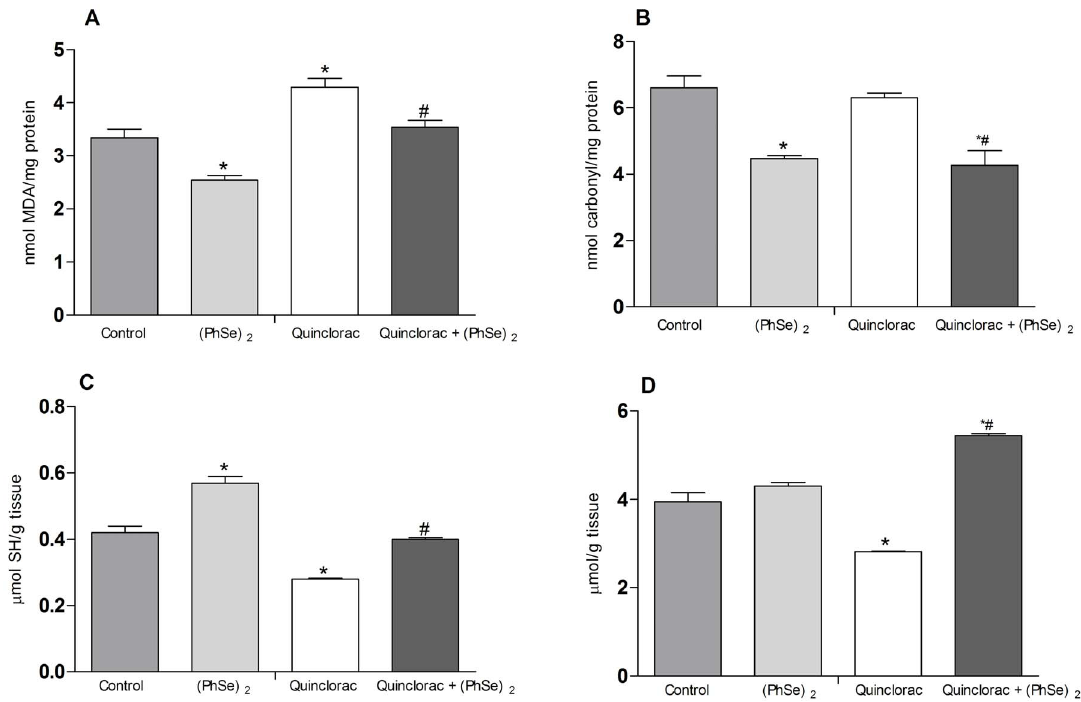
Figure 1. Oxidative parameters and non-enzymatic antioxidants. TBARS (A), protein carbonyl (B), NPSH (C), and ascorbic acid (D) in liver of silver catfish fed for 60 days with diets containing 0 or 3.0 mg/Kg of (PhSe) 2 and after exposed to quinclorac herbicide or to control conditions. Data are reported as mean ¡ SEM (n 5 12). (*) P , 0.05 as compared with the control group. ( # ) P , 0.05 as compared with the quinclorac